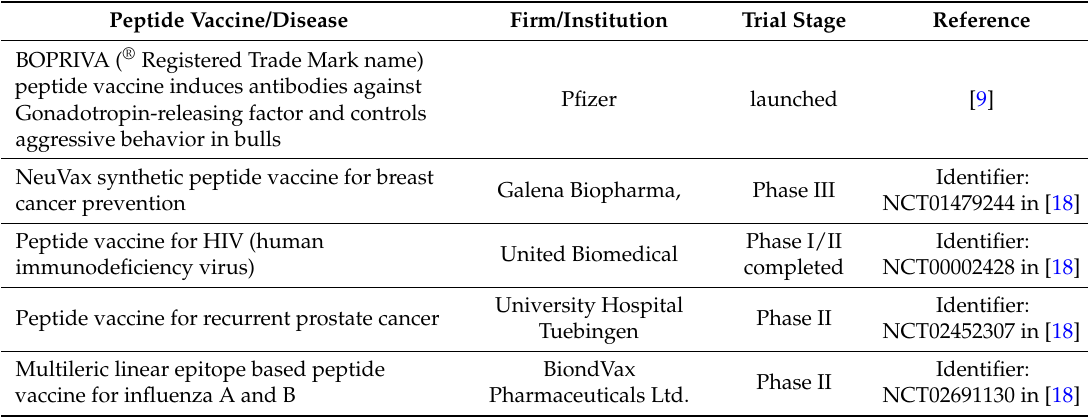
Table 1. A selection of peptide vaccines in various trial stages from the NIH website [18]. Peptide